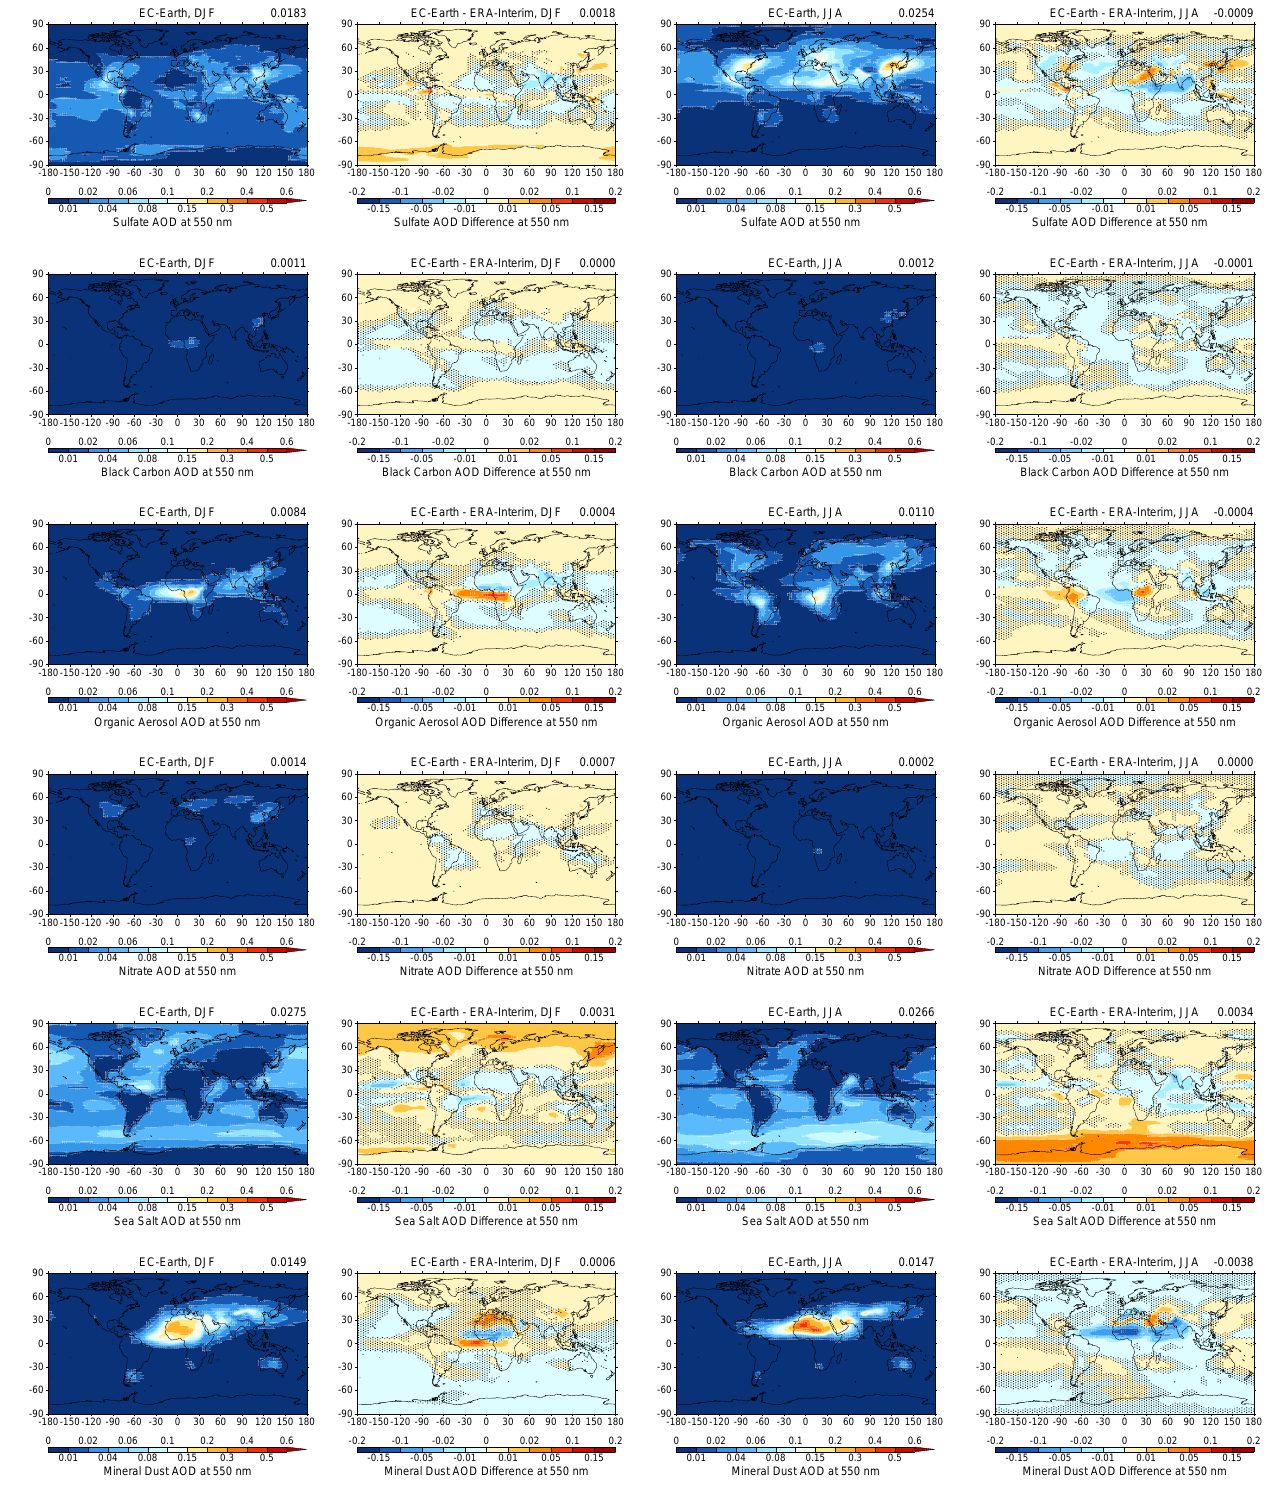
Figure A1. Contributions from the different aerosol components to the aerosol optical depth at 550nm in the reference EC-Earth simulation and the differences compared to the corresponding ERA-Interim simulation for boreal winter (left two columns) and boreal summer (right two columns). The global mean values of the displayed fields are indicated at the top of each